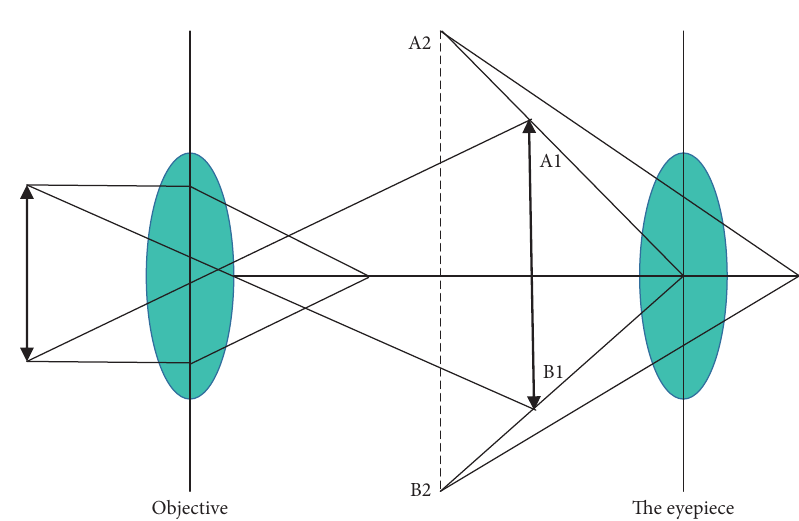
Figure 7: Optical microscopy.